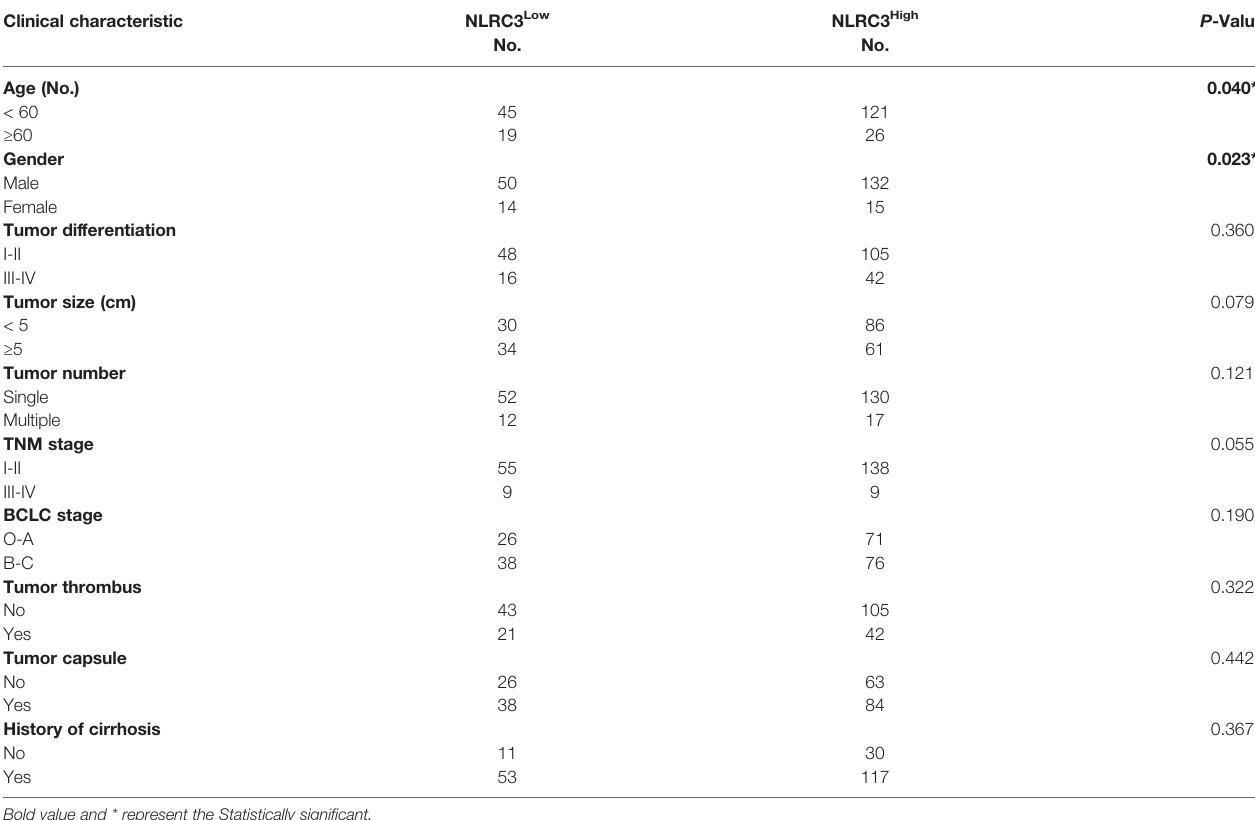
TABLE 1 | Correlation of clinicopathological parameters and NLRC3 expression. Clinical characteristic